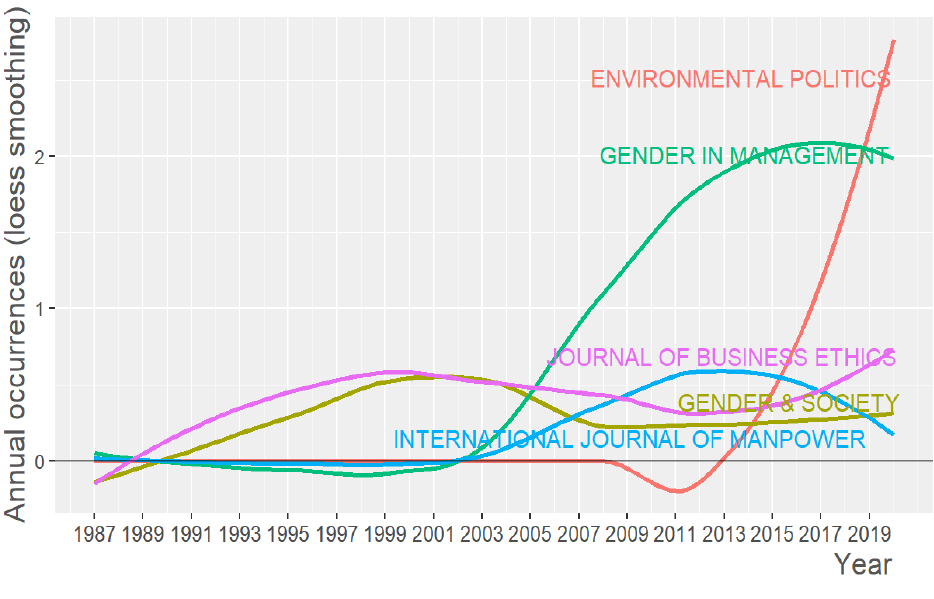
Figure 4. Source growth based on the number of publications per year.